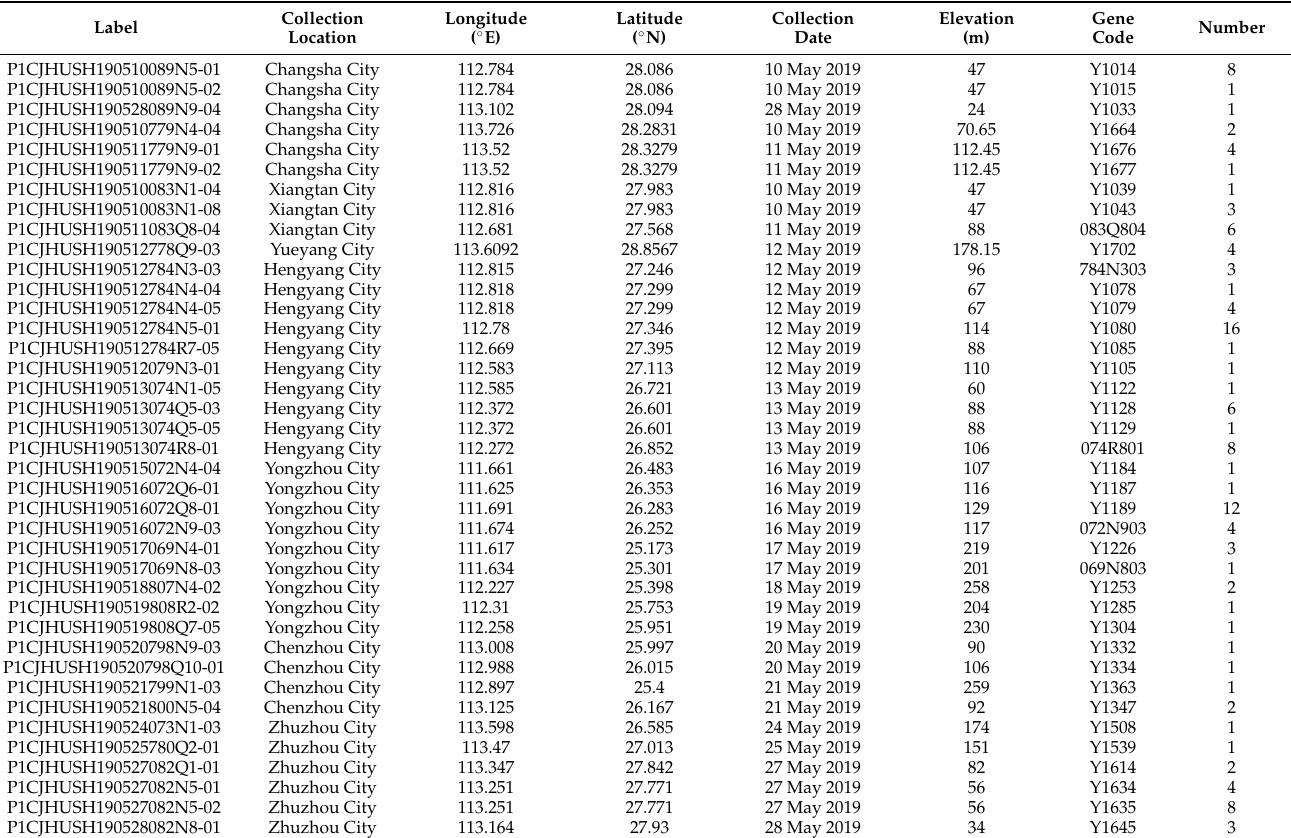
Table 1. Collection information on M. remanens sequenced in this